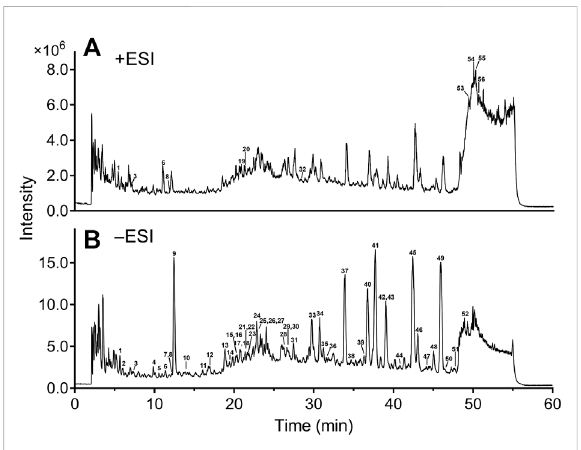
FIGURE 2 Total ion chromatograms of DHI in positive (A) and negative (B) ion modes. DHI: Danhong injection; ESI: electrospray ionization. Column: Agilent Zorbax SB-C18 (4.6 mm × 250 mm, 5 μ m); mobile phase A: 0.5% formic acid in water; mobile phase B: acetonitrile; solvent gradient: 0 – 15 min, 2 – 10% B; 15 – 20 min, 10 – 17% B; 20 – 45 min, 17 – 28% B; 45 – 48 min, 28 – 60%B;48 – 53 min,60%B; fl owrate:1.0 ml/min;temperature: 35 ° C; injection volume: 5 μ